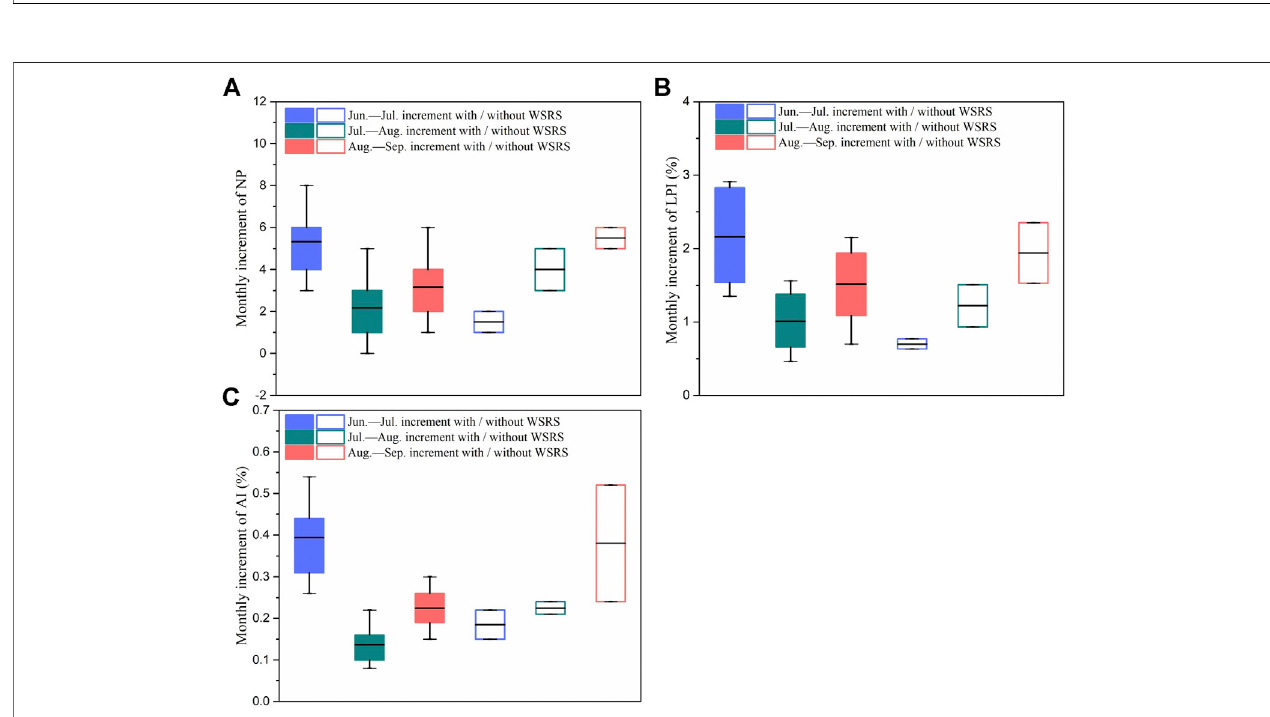
FIGURE 5| Ranges and means of monthly increment of (A) NP(number ofpatches) (B) LPI (largest patch index) and (C) AI (aggregation index) ofS. alterni fl ora for sub-region d from June to September during 2011 to 2018.